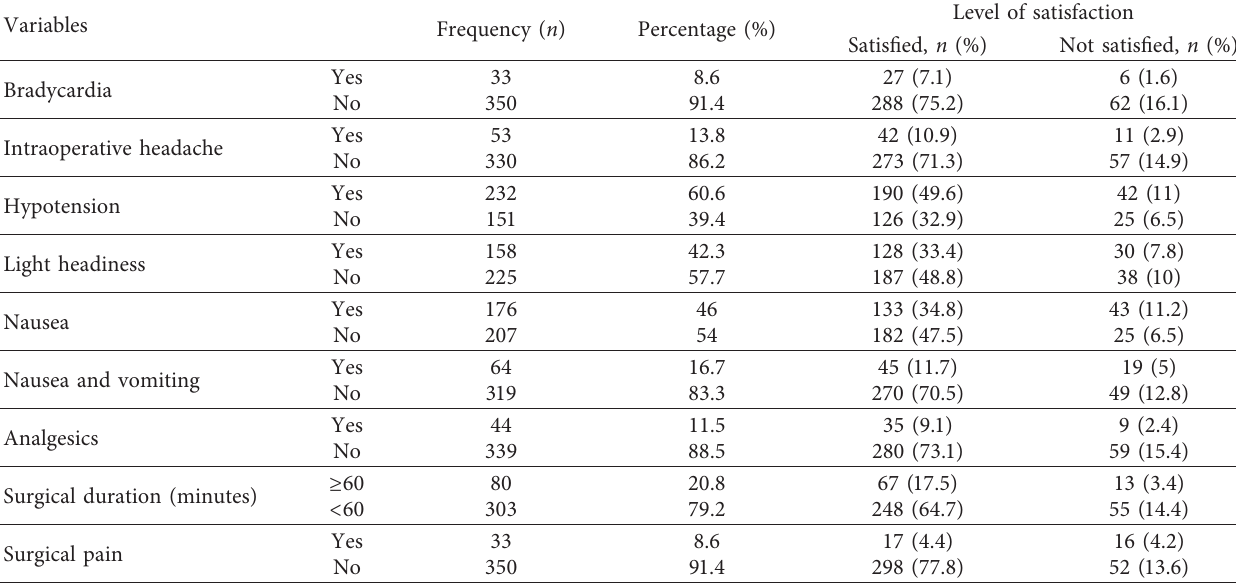
Table 3: Intraoperative anesthesia-related factors of parturients at University of Gondar Comprehensive Specialized Hospital, Northwest Ethiopia, 2019 ( N � 383).